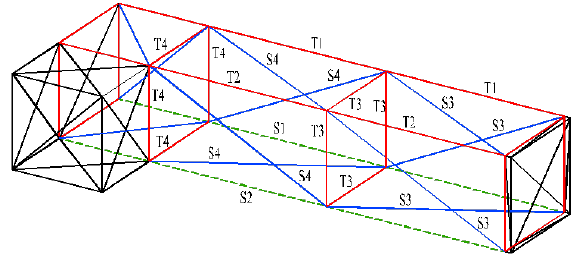
Figure 5: The particular members of the B3 beam system reliability